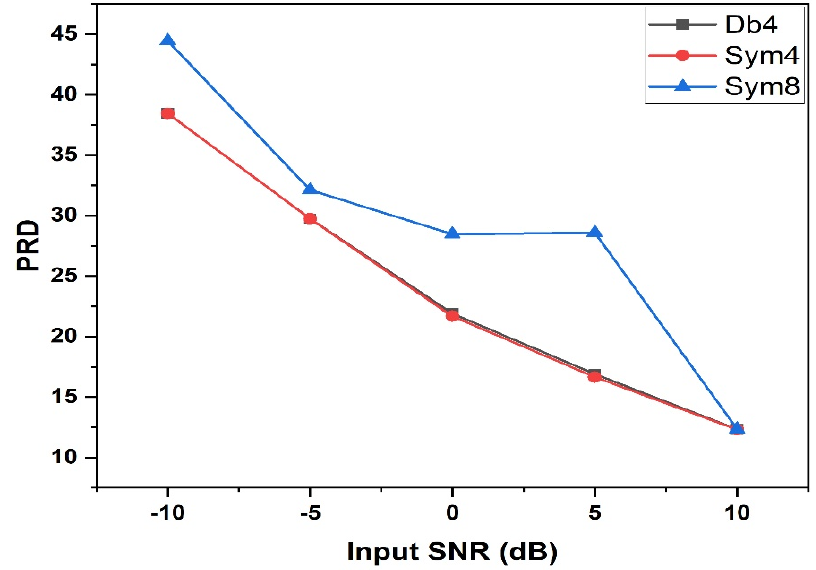
Figure 5. Performance comparison between various types of wavelets used for record 100.